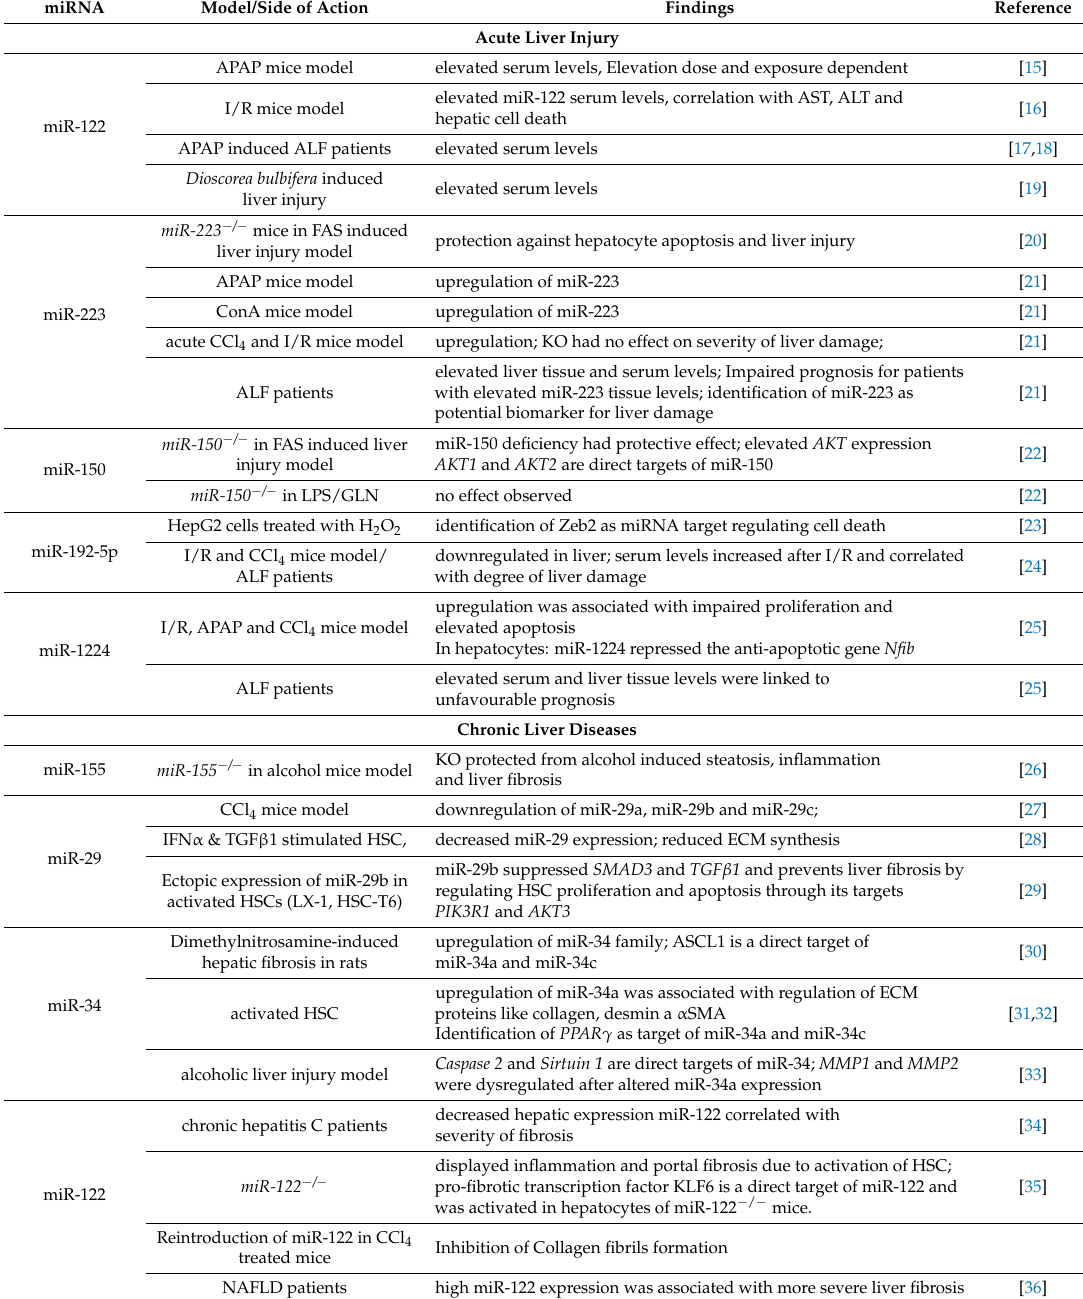
Table 1. Representative overview on miRNAs involved in acute in chronic liver diseases.